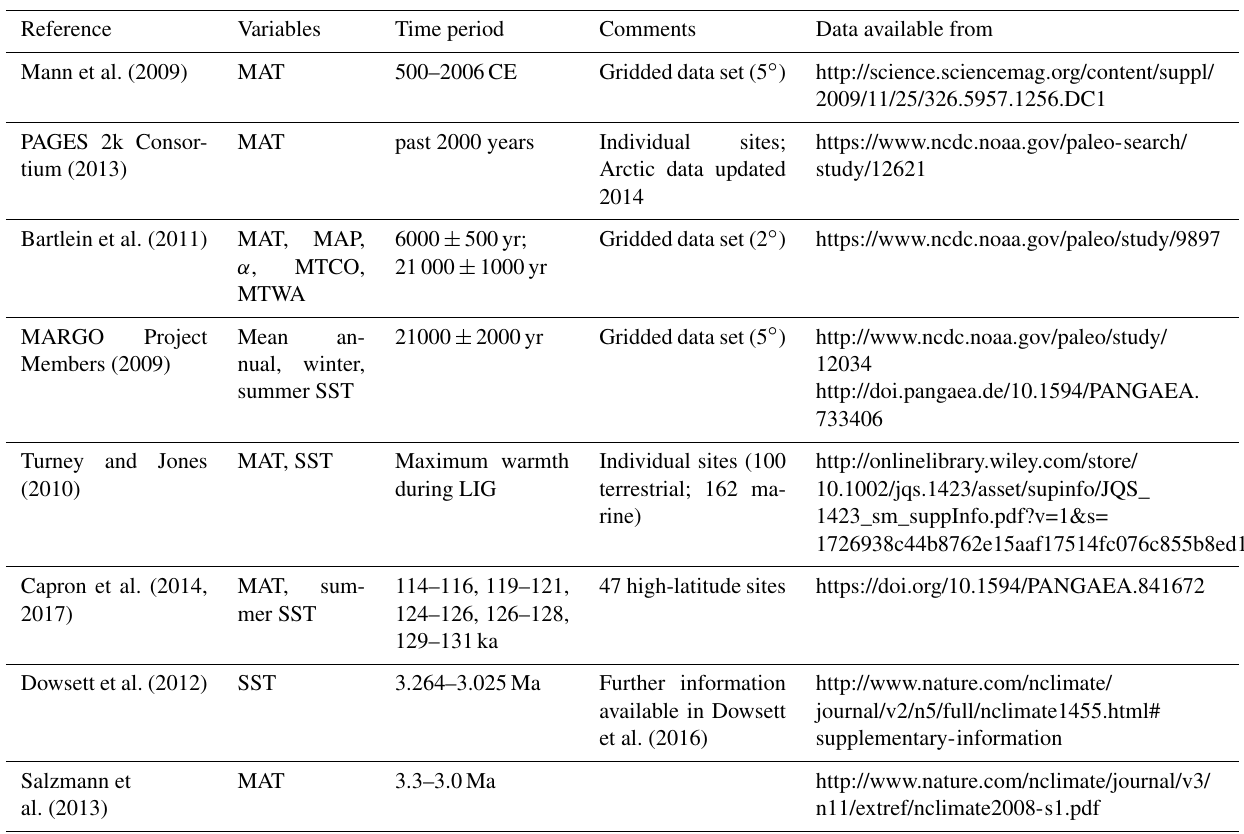
Table 3. Examples of data syntheses for the PMIP4-CMIP6 periods. MAT: mean annual temperature; MAP: mean annual precipitation; α : ratio of the actual evaporation over potential evaporation; MTCO: mean temperature of the coldest month; MTWA: mean temperature of the warmest month; SST: sea-surface